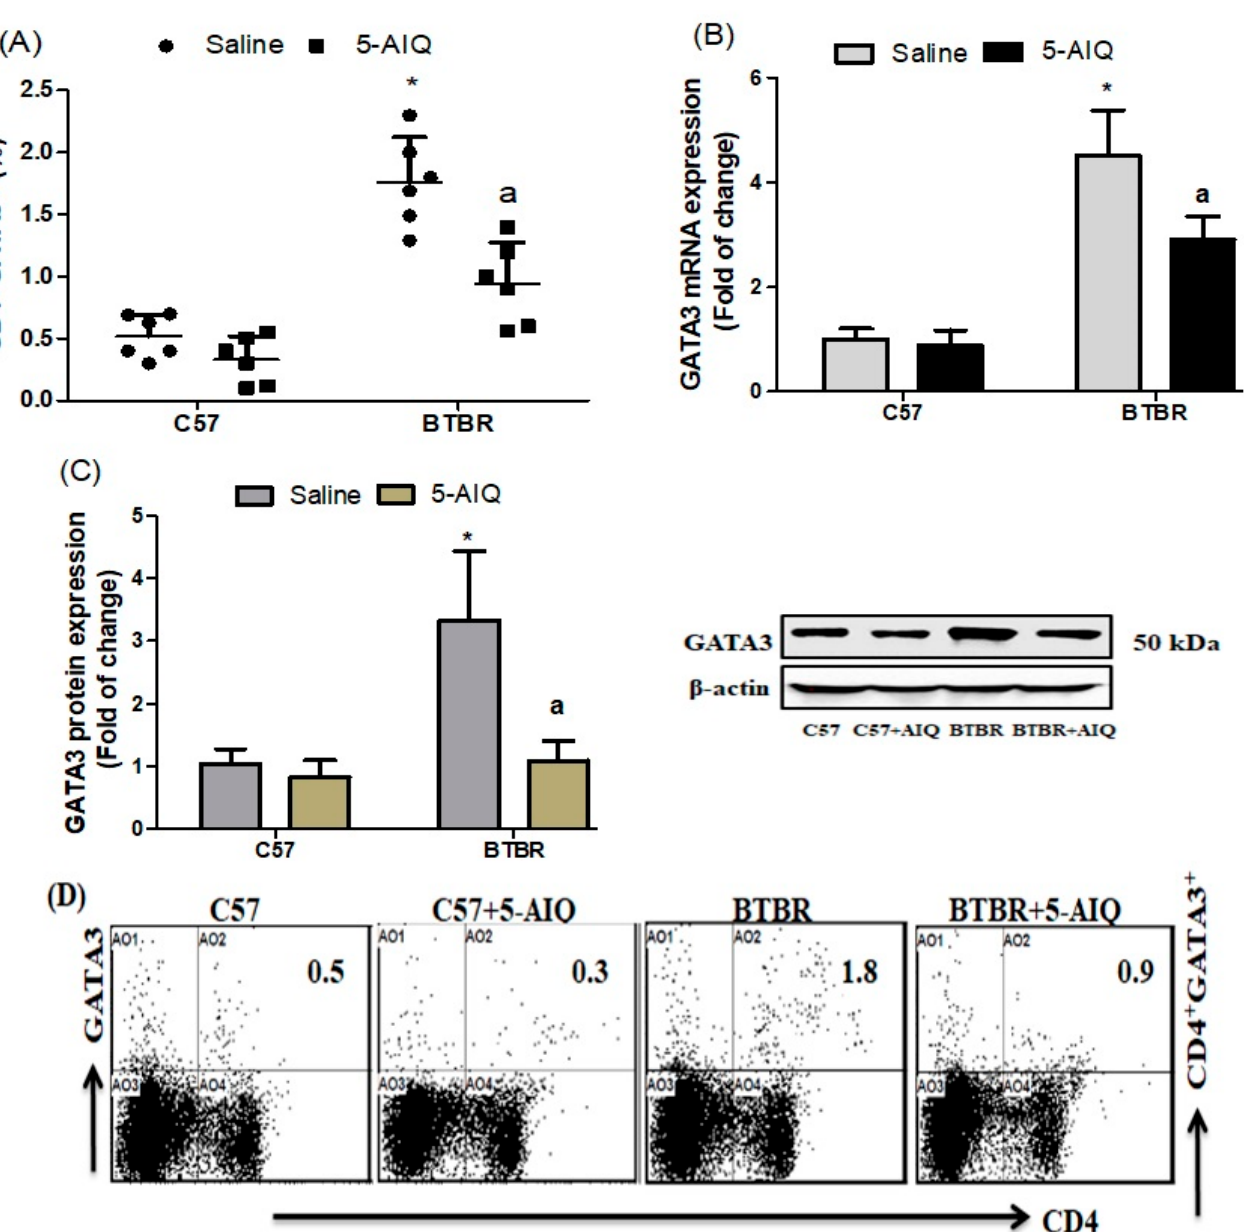
Figure 4. Effects of 5-AIQ on expression of GATA3 in C57 and BTBR mice. ( A ) Flow cytometry analysis of intracellular GATA3-producing CD4+ T cells from mouse spleens (Strain effect, F(1,20) = 67.84, p < 0.0001; Treatment effect, F(1,20) = 20.07, p < 0.0002, Treatment x Strain effect, F(1,20) = 7.728, p < 0.0116); ( B ) RT-qPCR analysis of levels of GATA3 mRNA from mouse brain tissue (Strain effect, F(1,20) = 171.5, p < 0.0001; Treatment effect, F(1,20) = 16.70, p < 0.0006, Treatment x Strain effect, F(1,20) = 12.49, p < 0.0021) and ( C ) Western blotting analysis of levels of GATA3 protein from mouse brain tissue (Strain effect, F(1,20) = 27.36, p < 0.0001; Treatment effect, F(1,20) = 24.79, p < 0.0001, Treatment x Strain effect, F(1,20) = 17.18, p < 0.0005). ( D ) Cells were gated on forward-side scatter dot plots; the dot plots represent the percentages of CD4+GATA3+ cells. Bar graphs represent the percentage of CD4+GATA3+ population. The control C57 and BTBR mice received saline intraperitoneal injection. Treated BTBR and C57 mice received 5-AIQ (1.5 mg/kg) via intraperitoneal injection once daily for ten days. The results are shown as the means ± SD, n = 6, each group; * p < 0.05 compared with saline-treated C57 mice; a p < 0.05 compared with saline-treated BTBR